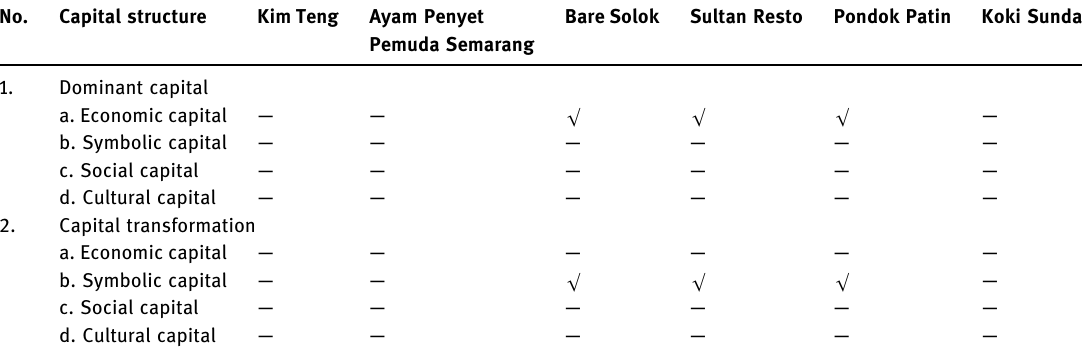
Table 2: The fi eld of identity